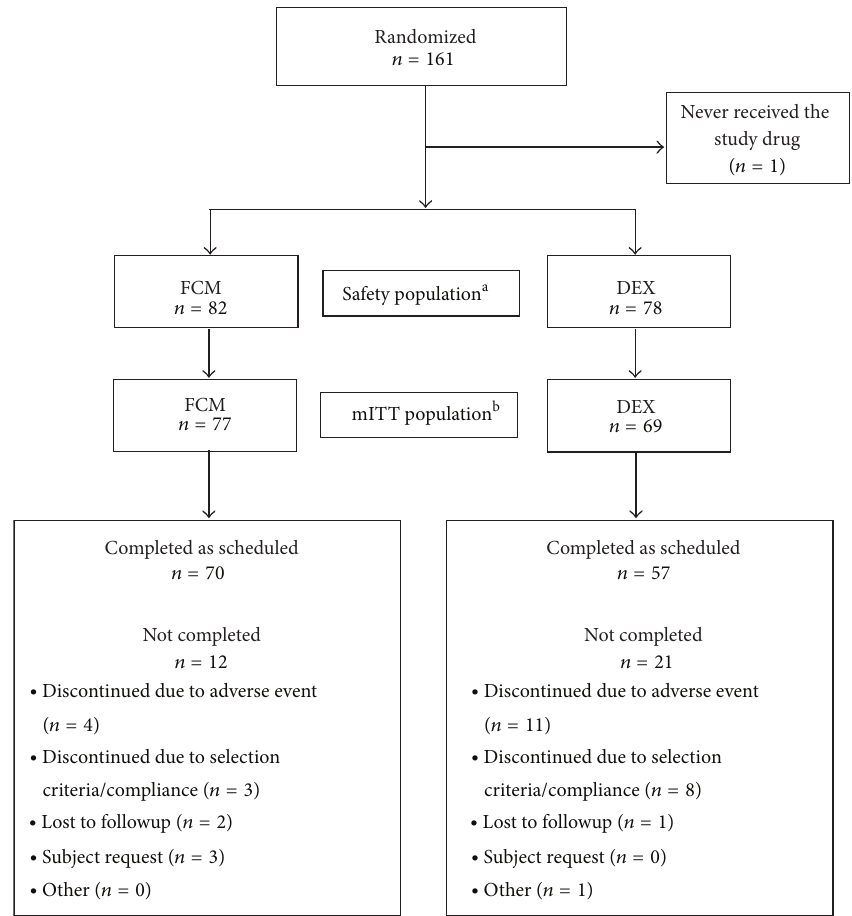
Figure 1: Flowchart of the study. a All subjects treated with FCM or DEX were included in the safety population. b mITT: all subjects in the safety population with 2 baseline hemoglobin values (with < 1g/dL difference between the 2 values) and at least 1 postbaseline hemoglobin value on or before Day 49 or intervention date, whichever came